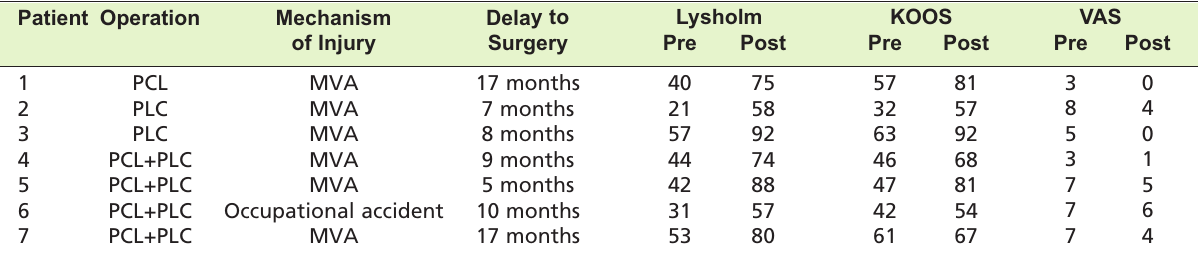
Summary of patients’ demographic characteristics cause of injury, delay to surgery and functional Table I: